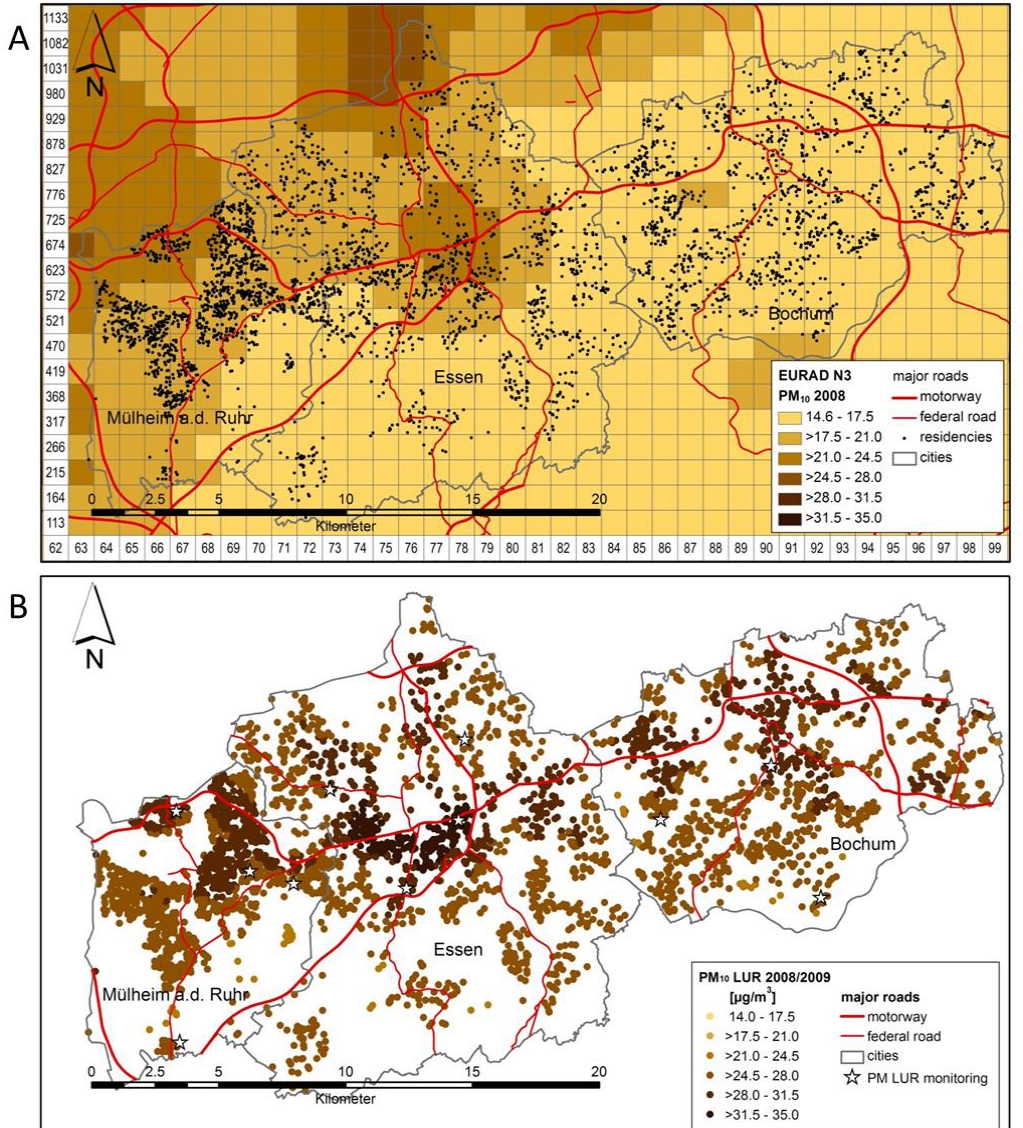
Figure 2. Spatial distribution of EURAD-CTM (1 km 2 , yearly mean 2008, ( A )) and ESCAPE-LUR (yearly mean October 2008–October 2009, ( B )) at 4809 residences within the HNR study area for PM 10 .